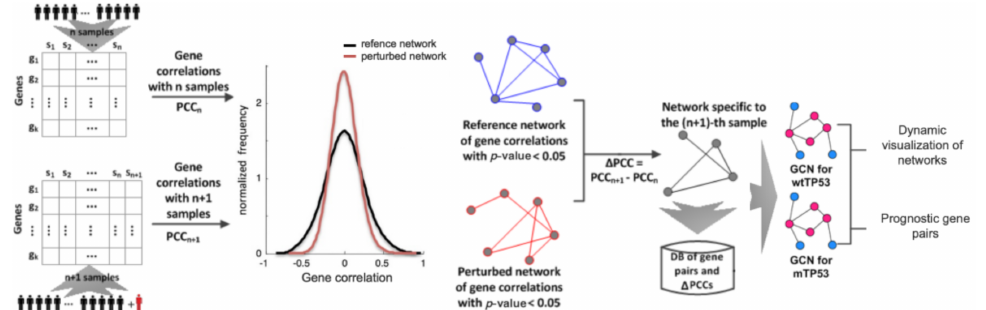
Figure 1. Schematic overview of the framework for constructing gene correlation networks (GCNs) and obtaining prognostic gene pairs for two groups of breast cancer patients. wtTP53: a group of breast cancer patients with a wild-type TP53 gene. mTP53: a group of breast cancer patients with somatic mutations in the TP53 gene.